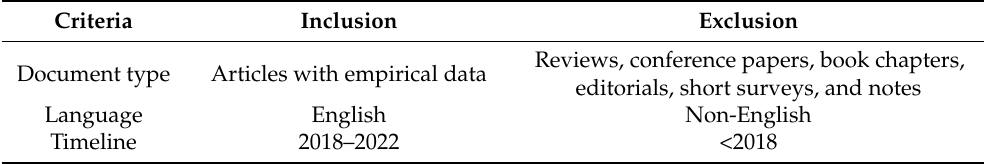
Table 2. The inclusion and exclusion criteria of the